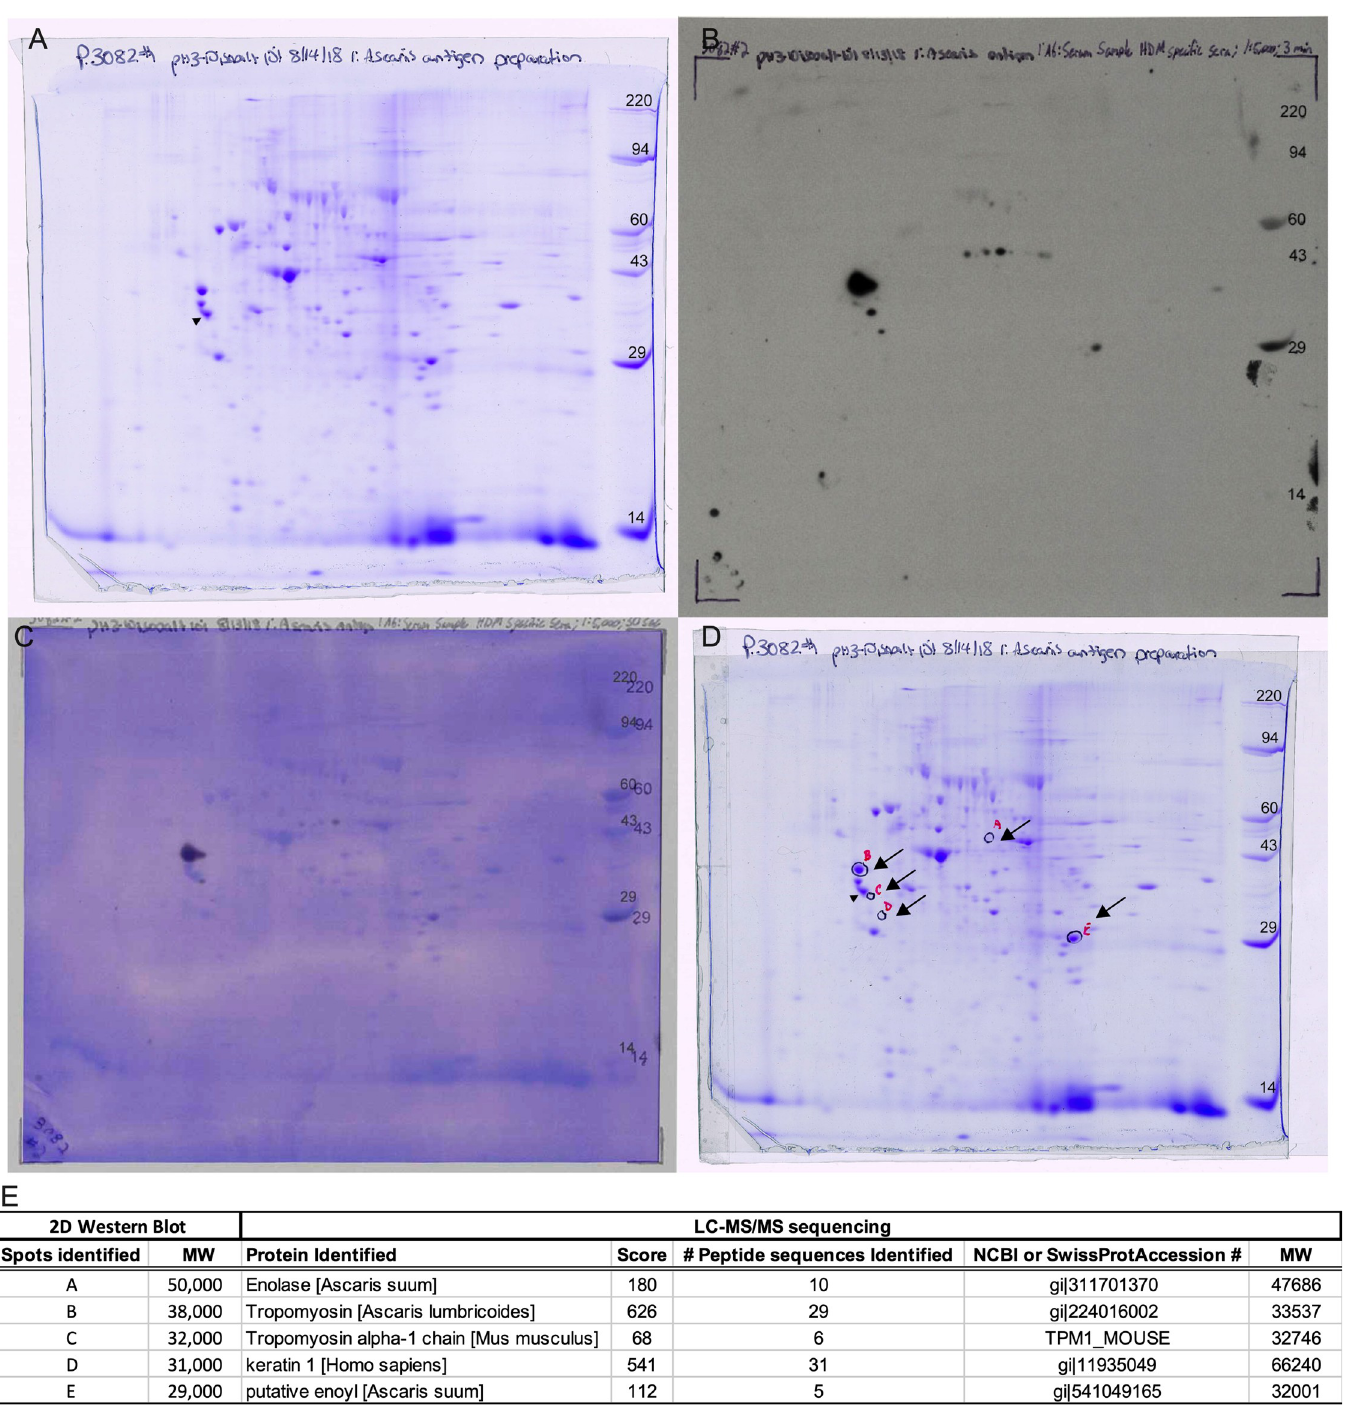
Fig 3. Proteomics profile of Ascaris lung-stage larval antigens that cross-react with HDM-driven antibodies. Coomassie blue-stained 2-D SDS-PAGE gel of Ascaris lung-stage larval antigens (A). Immunoblot of lung-stage larval crude antigen using a serum pool of HDM-allergic BALB/c mice (B) and the reactive bands (arrows) in the gel for protein excision based on the overlay (C) of Panels A and B (D). Results of the LC-MS sequencing of the A-E excised spots showing the protein identification and their respective molecular weight, based on the peptide sequence similarities using NCBI All Organisms, NCBI Mammalia & SwissProt All Organisms databases (E).